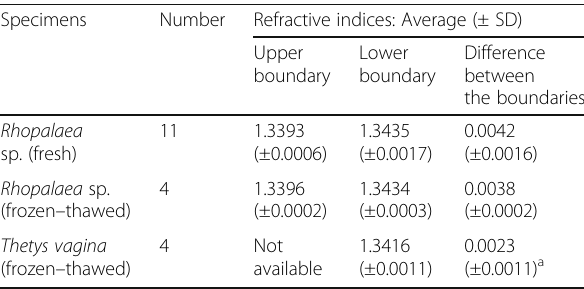
Table 1 Refractive indices of the tunic measured by an